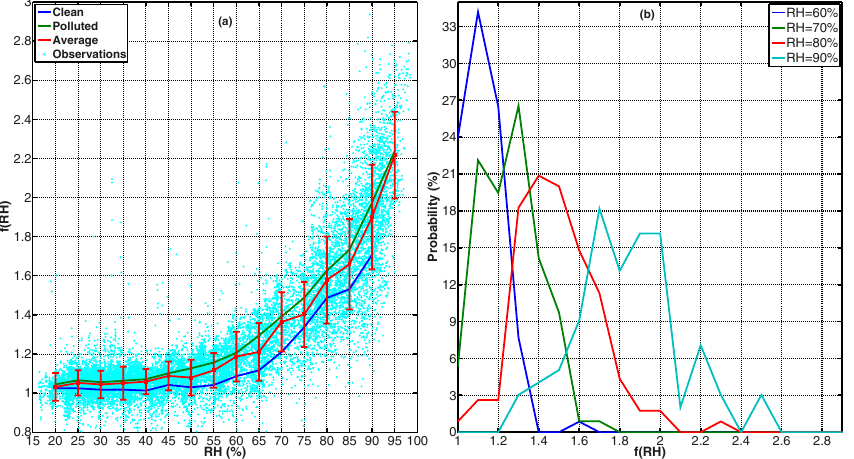
Figure 2. (a) The mean f (RH) under clean, average (mean ± 1 σ) , and polluted conditions. The scattered dots represent the in situ obser- vational results, and lines denote the mean f (RH) values corresponding to different pollution cases. (b) Probability distribution functions (PDFs) of f (RH) at four specific RHs (RH = 60, 70, 80, and 90%,